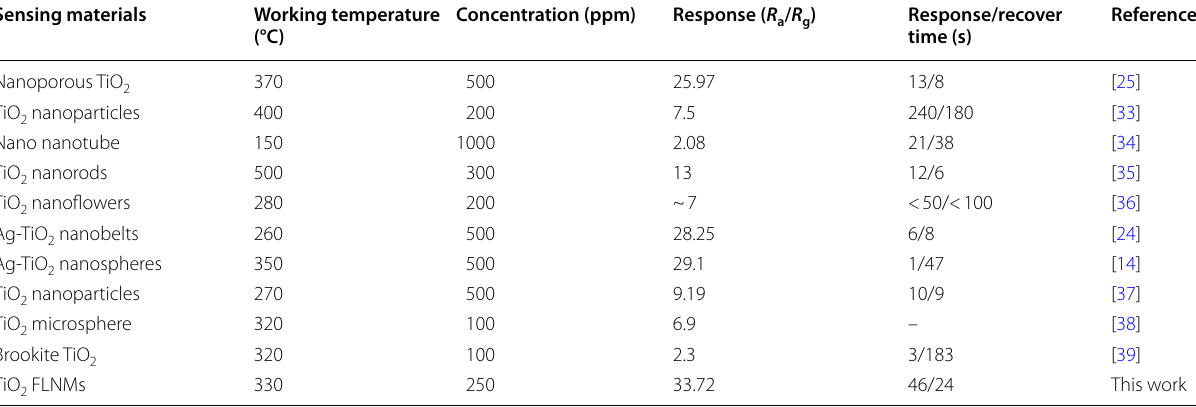
nanostructures toward acetone gas sensing performances 2